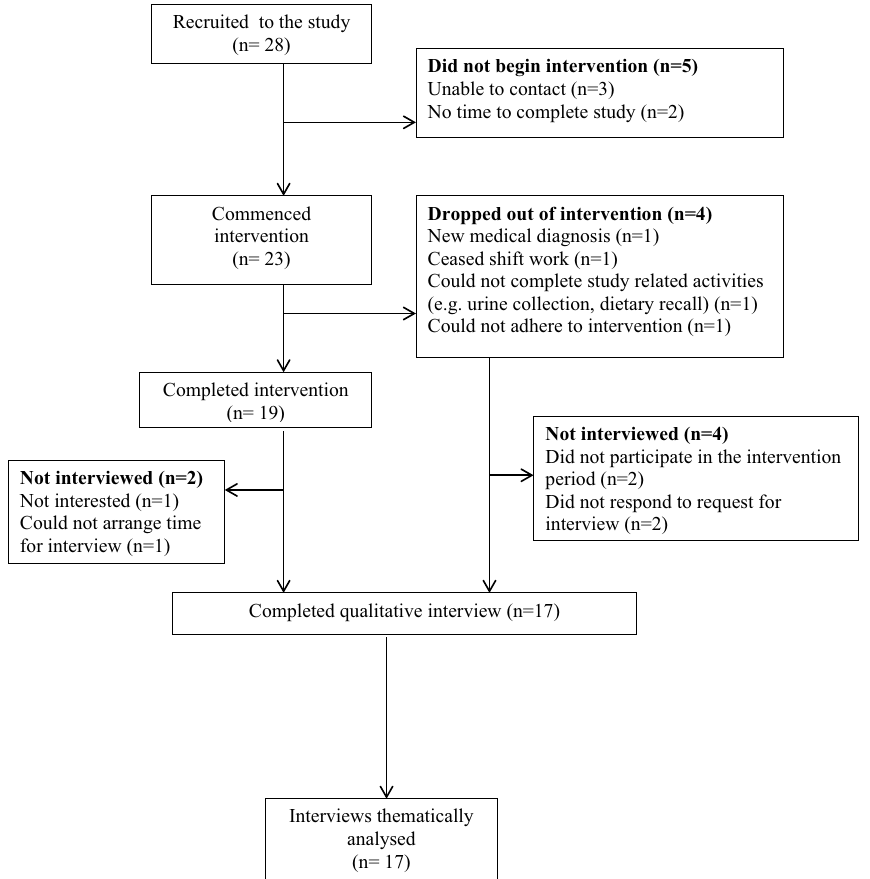
Figure 1. Flow diagram of participant recruitment to the qualitative evaluation.